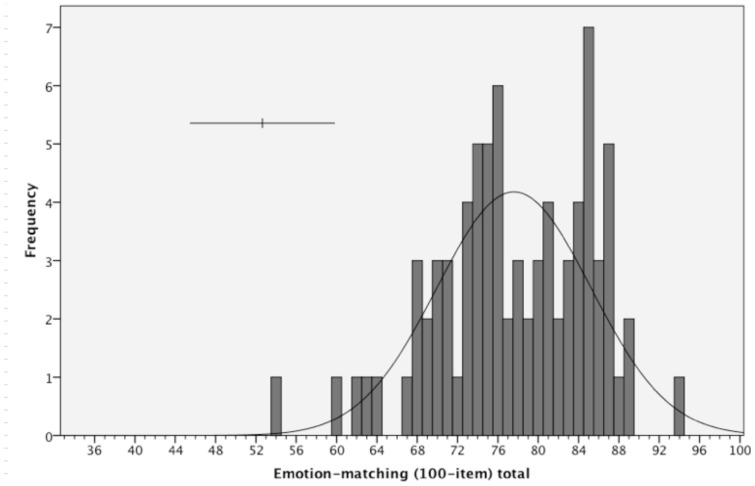
Frequency distribution for scores on the 100-item Emotion-matching task (chance performance = 33).Error bars indicate 95% confidence interval of individual scores based on task reliability.